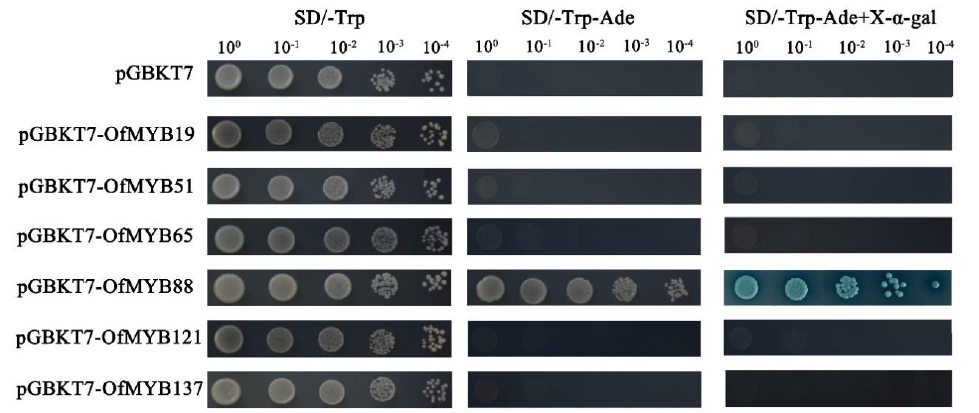
Figure 7. Transcriptional activation activities of OfMYB proteins. The construct of the five vectors pGBKT7-OfMYBwastransformedintoAH109anddetectedonSD / -Trp, SD / -Trp / -Ade, andSD / -Trp / -Ade pGBKT7-OfMYB was transformed into AH109 and detected on SD/-Trp, SD/-Trp/-Ade, and SD/-Trp/- with X- α Ade with X- α -gal.